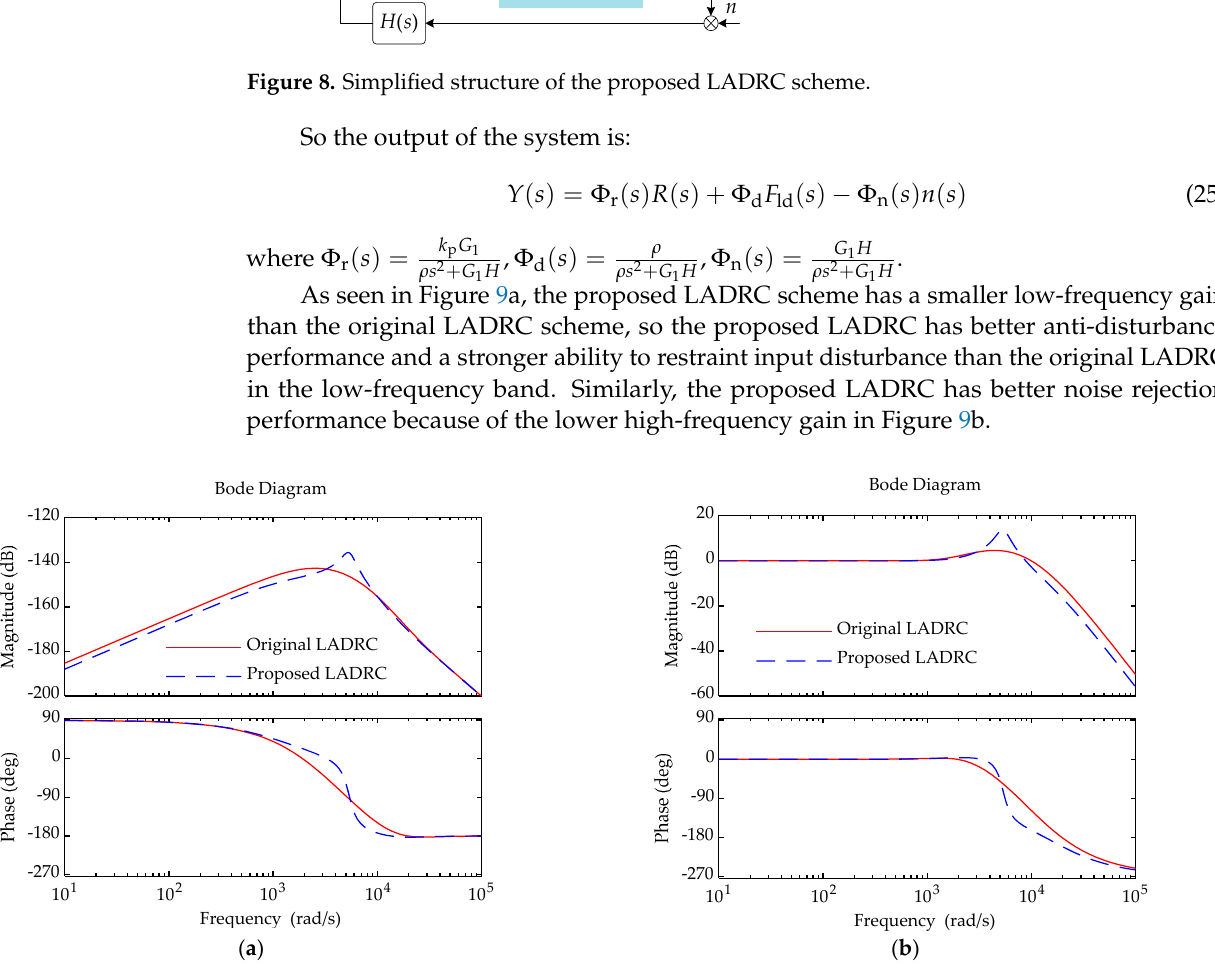
Figure 9. Bode diagrams with different schemes: ( a ) Disturbance term Φ ( s ) ; ( b ) Noise term Φ n ( s ) .